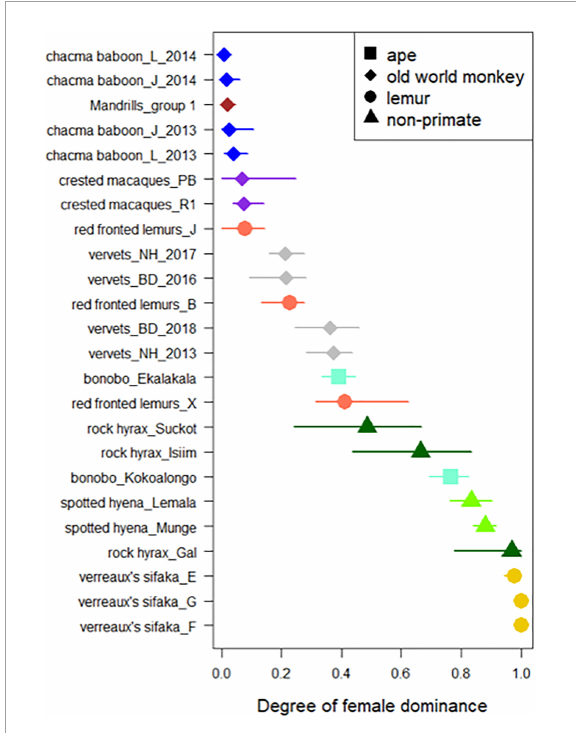
FIGURE2 Distribution of the female dominance indices in the 24 study groups. Each line represents a study group during a given year. The symbol depicts the mean across all seven female dominance indices and the line the range of these indices. Each species is depicted with a different color. Apes, old world monkeys, lemurs and non-primates are depicted using squares, diamonds, circles and triangles,